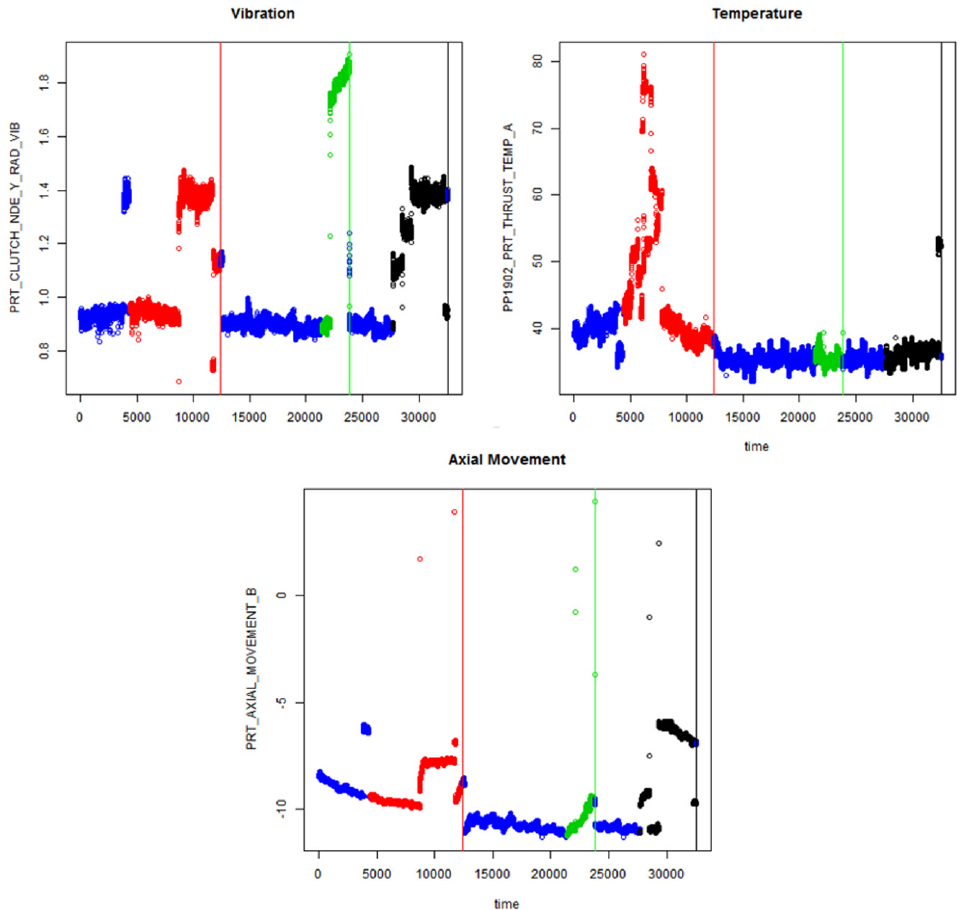
anomalies associated with the type of equipment failure and to assign the state of the equipment to each feature vector. In Figure 12, the red color represents the state for leakage, green represents misalignment, black represents bearing damage, and blue represents the steady state. The vertical line shown in Figure 12 indicates the time when each type of failure occurred.